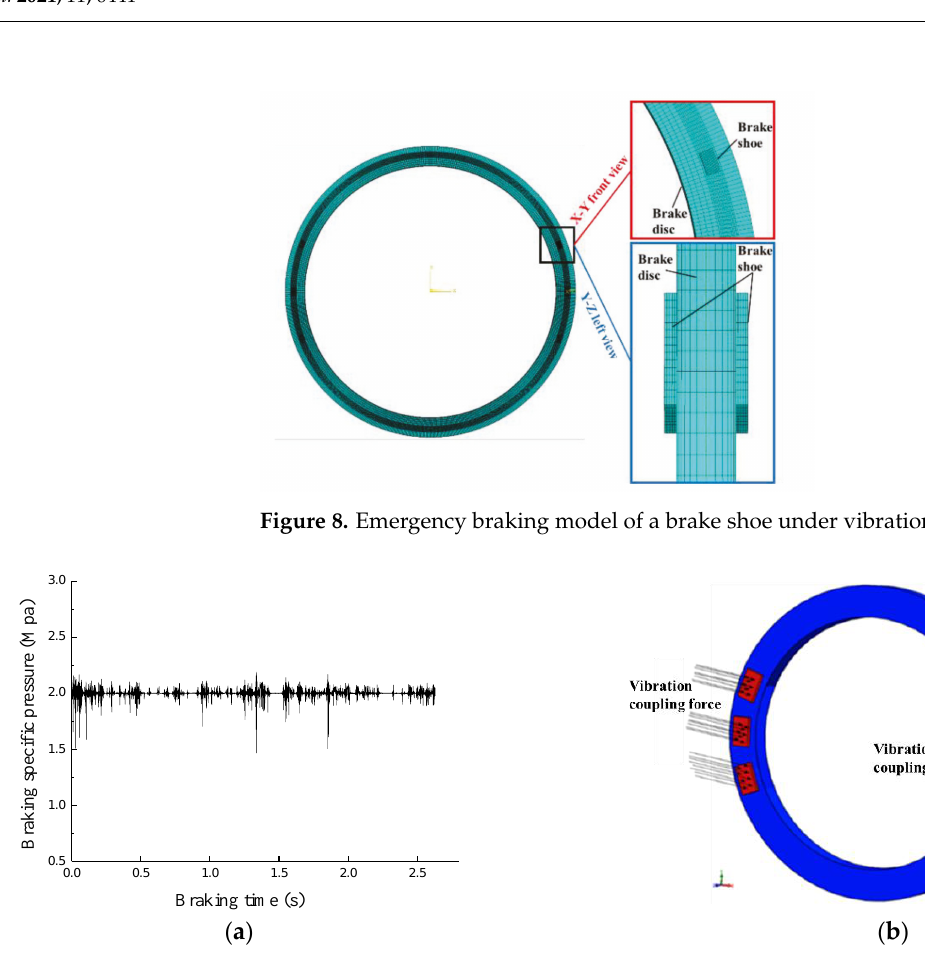
Figure 9. The specific braking pressure and braking force application of the brake shoe. ( a ) Specific braking pressure of the brake shoe; ( b ) schematic diagram of braking force application of the brake shoe.